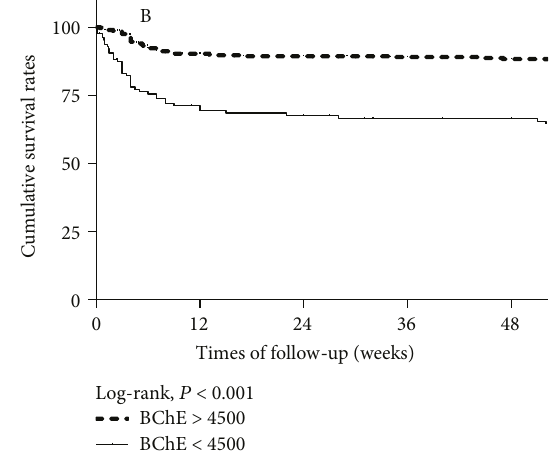
Figure 5: Kaplan – Meier survival curves according to BChE levels. The BChE level a ff ects mainly 1-year mortality. One-year cumulative survival for patients with a low BChE is 64.5 ± 4.5% and 87.6 ± 1.8% for patients with a normal BChE level (log-rank, P < 0 001